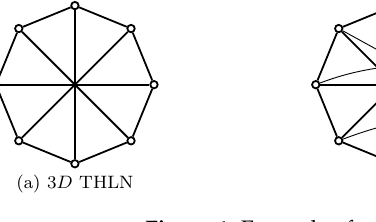
Figure 1. Example of weak vertex-pair.